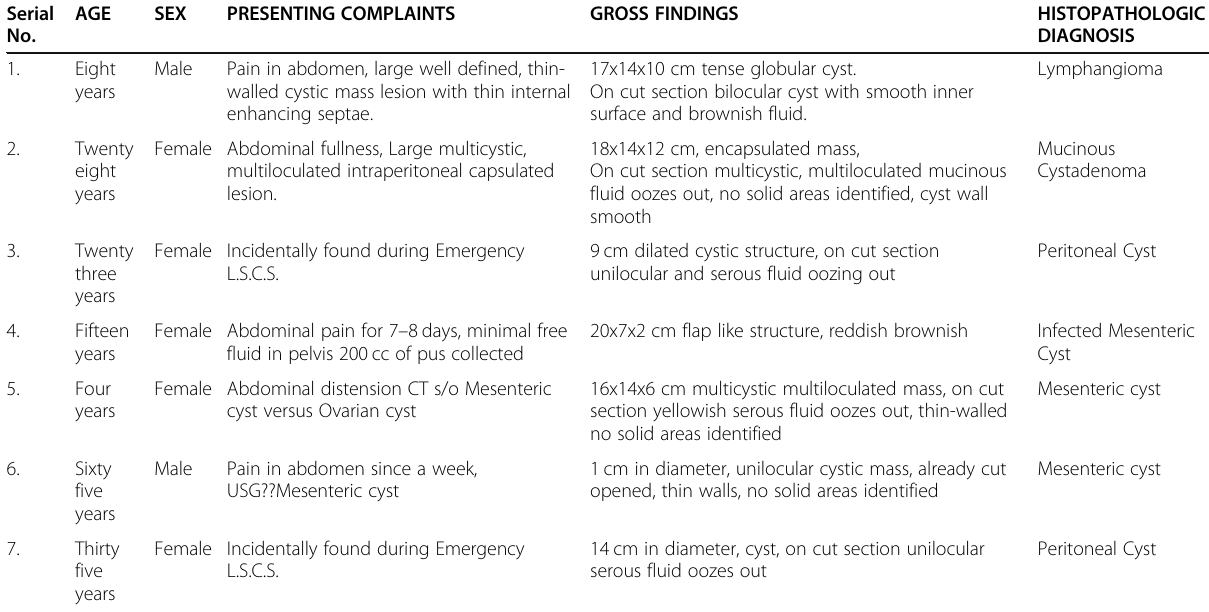
Table 1 summarising the histopathological diagnoses of the cystic neoplasms that were studied alongwith mode of presentation and imaging findings